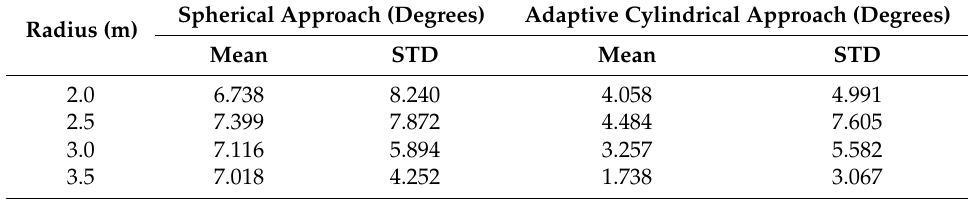
Figure 13. Angles between the surface normal vector calculated and the true one: ( a,c,e,g ) Spherical and ( b,d,f,h ) Adaptive cylindrical approaches applying different radii of 2.0 m ( a,b ); 2.5 m ( c,d ); 3.0 m ( e,f ); and 3.5 m ( g,h ). Table 1. Statistical evaluations of the angles between the surface normal vector calculated and the true